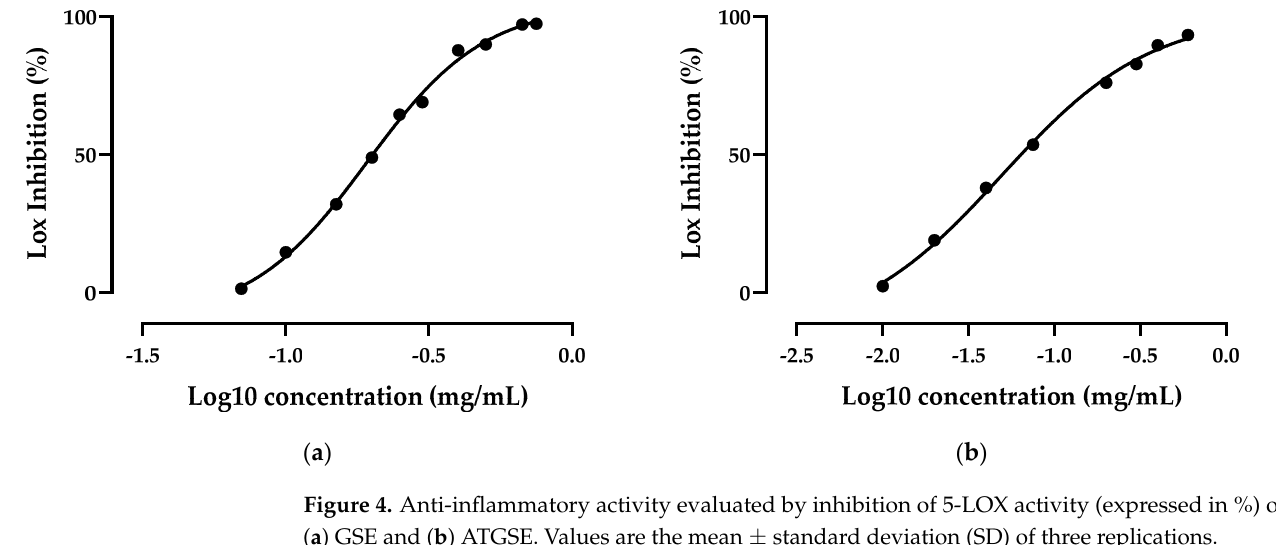
Figure 4. Anti-inflammatory activity evaluated by inhibition of 5-LOX activity (expressed in %) of ( a ) GSE and ( b ) ATGSE. Values are the mean ± standard deviation (SD) of three replications. Table 2. Anti-inflammatory activity evaluated by inhibition of COX-1 and COX-2 activity (expressed in %) of GSE and ATGSE. Values are the mean ± standard deviation (SD) of three replications. COX-1 Inhibitory COX-2 Inhibitory Compound Activity Activity (IC 50 mg/mL ± SD) (IC 50 mg/mL ± SD)